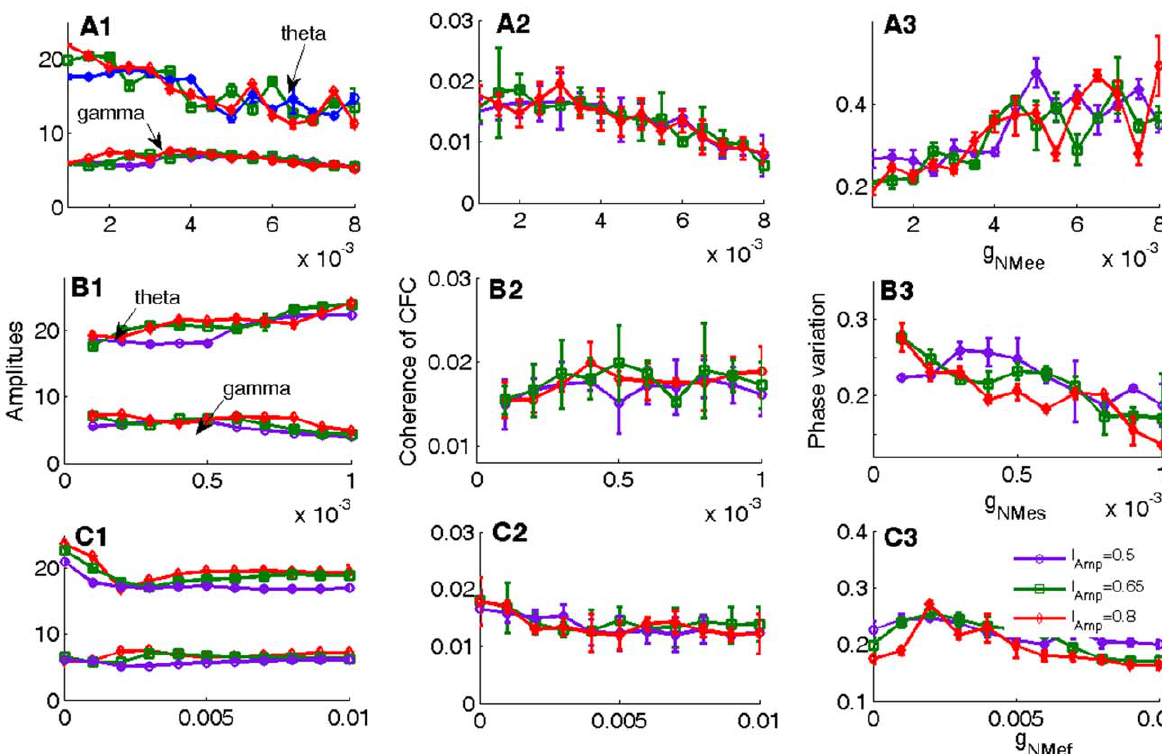
Figure 4. Effects of modulating NMDA conductances from excitatory to inhibitory neurons. The amplitudes of theta and gamma oscillations, the coherence of CFC, the phase variation vs. g NMes and g NMee are depicted, respectively. (A) shows the effect of increasing g NMee , (B) shows the effect of increasing g NMes , (C) shows the effect of increasing g NMef .